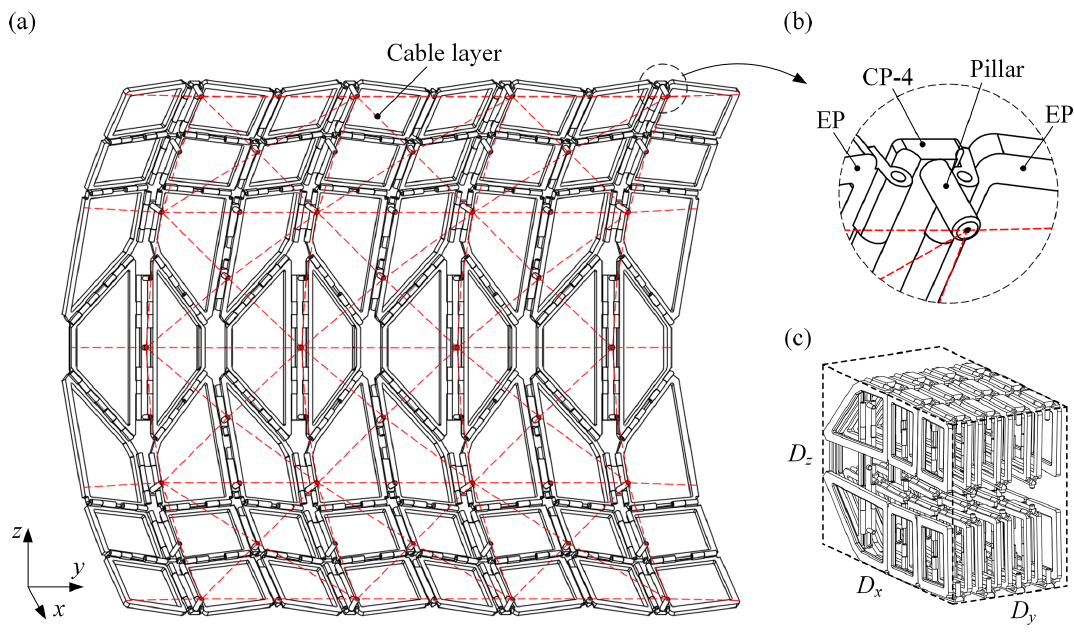
Figure 10. The parabolic cylindrical deployable antenna: (a) the deployable antenna, (b) the pillar installed on CP, (c) the fully folded configuration of the antenna.